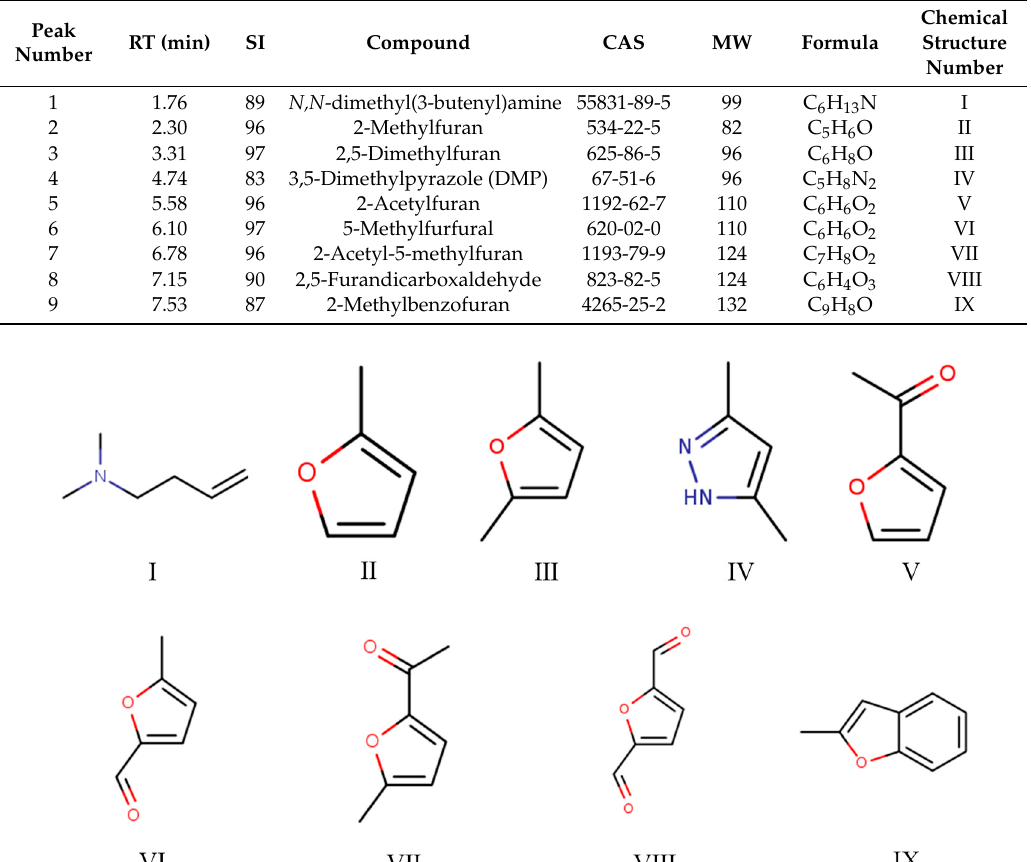
Chemical Structure Number